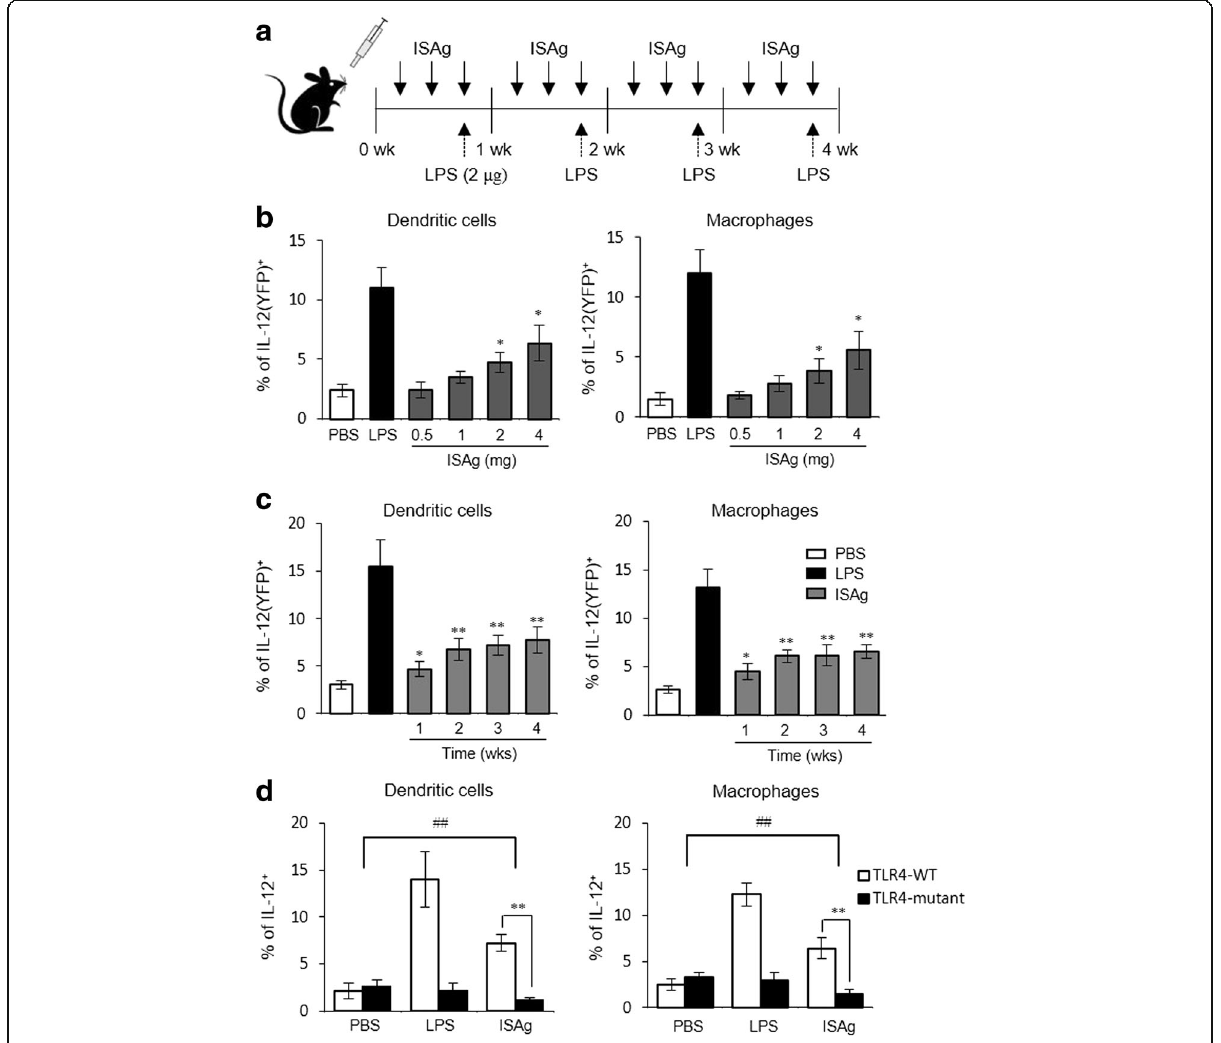
Fig. 5 Oral administration of ISAg induced IL-12 production in antigen-presenting cells via TLR4 signaling. a Yet40 B6 mice were exposed via the oral route using gavage with ISAg (0.5, 1, 2, or 4 mg/injection) or PBS three times per week for 4 weeks. As a positive control, mice were